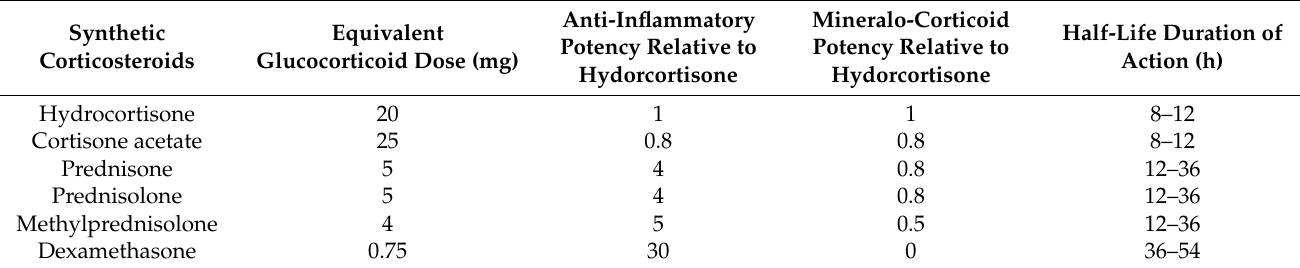
Table 1. Corticosteroid potency